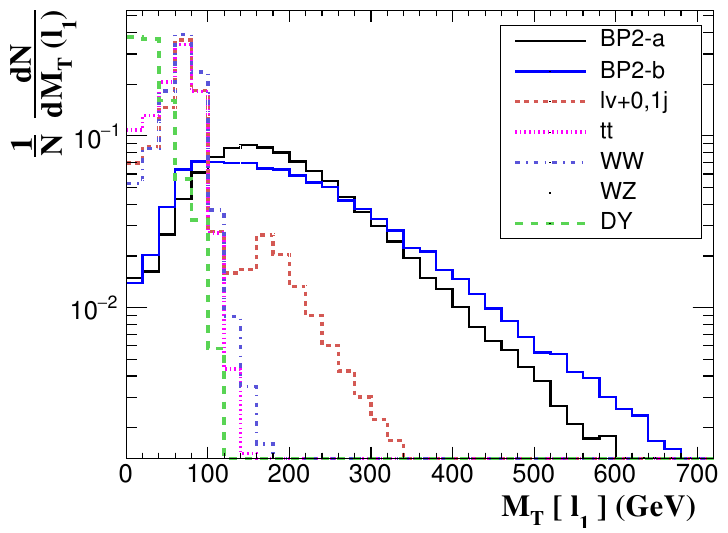
Figure 11 . Normalized distribution for M T ( l 1 ), the transverse mass of the leading lepton for SUSY signal BP2-a and BP2-b against the dominant SM backgrounds after preselection cut M1